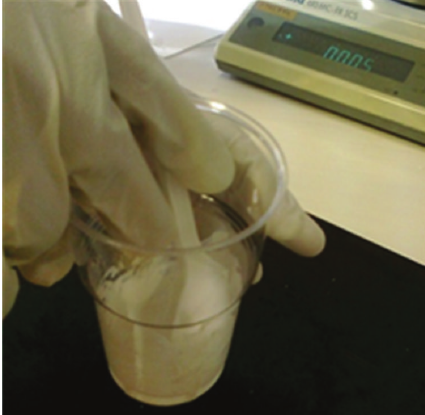
Figure 2: Vigorous mixing of PDMS ceramic powder with PDMS mixture.